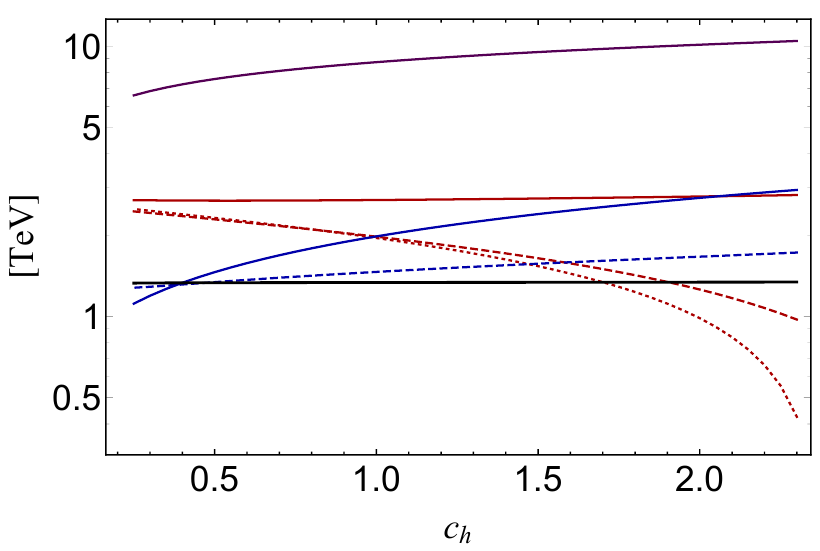
Figure 3 . Sfermion mass spectra at c u = c d = (cid:0) 2 by varying c h : Other parameter sets are same as in (cid:12)gure 2. The purple line is the SUSY scale represents m ~ u ( m ~ u ; m ~ ). The blue solid (dashed) line shows m ~ e d R L R solid line shows the bino-like neutralino